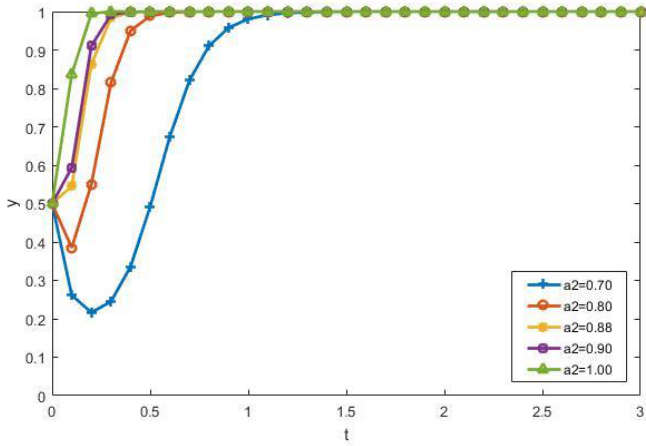
Figure 10. The impact of a 2 on the evolutionary results.